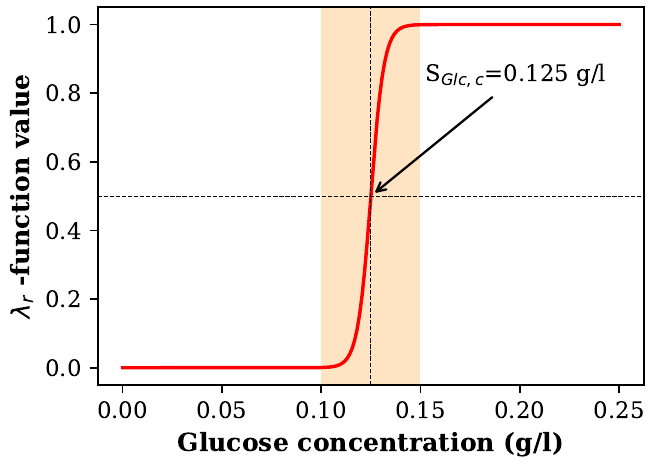
Figure 3. Shift function used to obtain a metabolism transition between aerobic fermentation and respiration processes over the glucose concentration range of 0.10–0.15